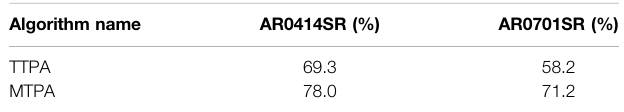
TABLE 1 | Win rates of TTPA and MTPA algorithms over NNA. For a given set of initial conditions (initial position of pursuers and evaders), if TTPA takes less total time to capture all the evaders than NNA, it is considered a win for TTPA. While if MTPA takes less time to capture the last evader (maximum capture time) than NNA, it is considered as a win for